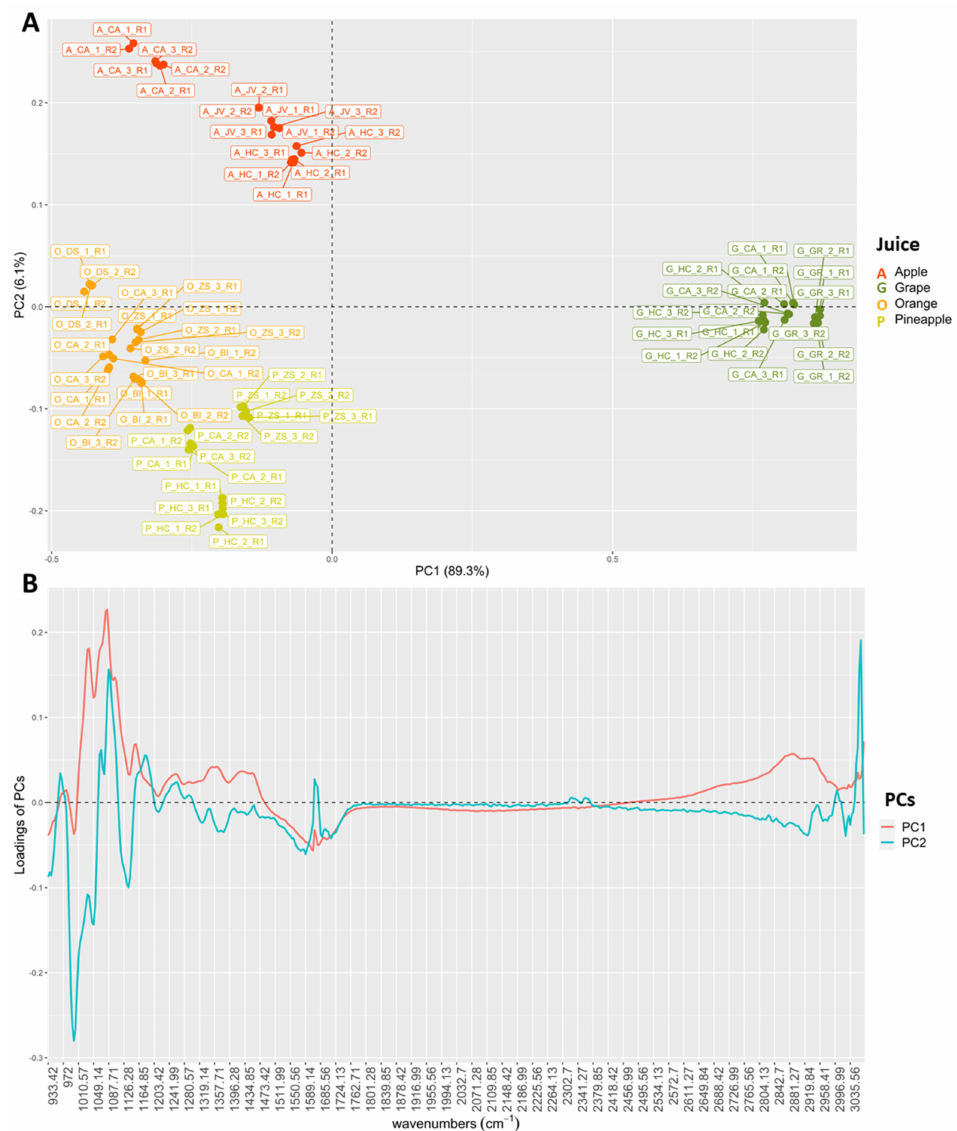
Figure 2. ( A ) Representation of the scores obtained using the FT-IR spectrum of all the pure juice sam- ples (D 76 × 540 ) as a function of the first two principal components (PC1 and PC2). ( B ) Representation of the loadings of the first two